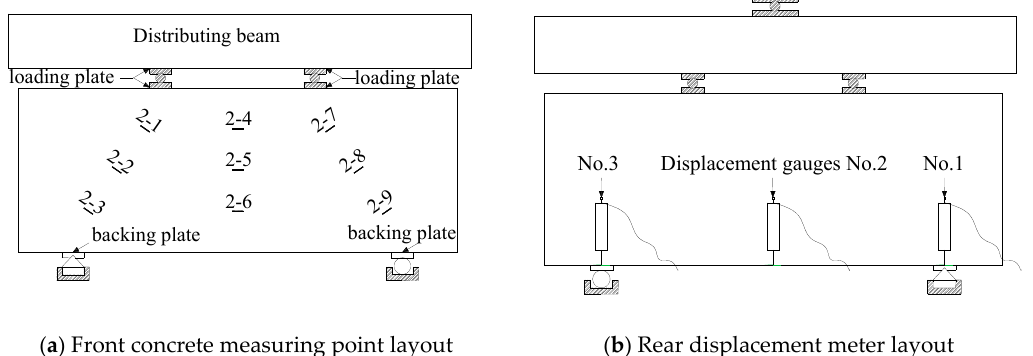
Figure 3. MDB2 rebar and concrete strain gauge layout.